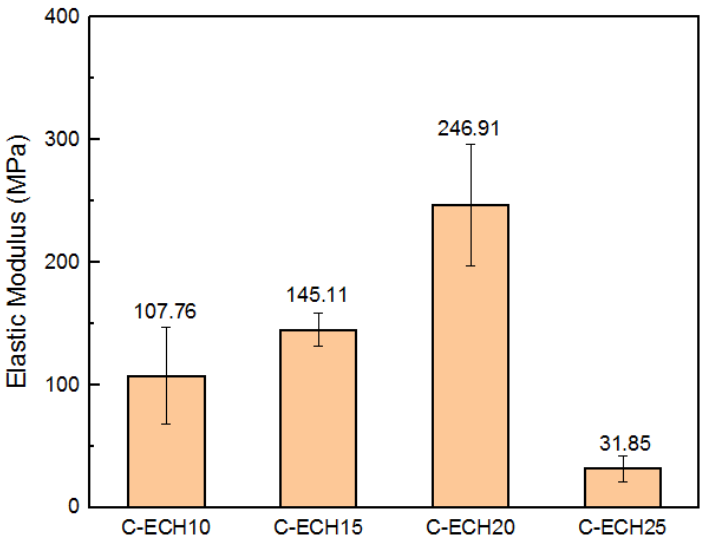
Figure 6. Elastic modulus of the cellulose bioplastic samples at various ECH concentrations.